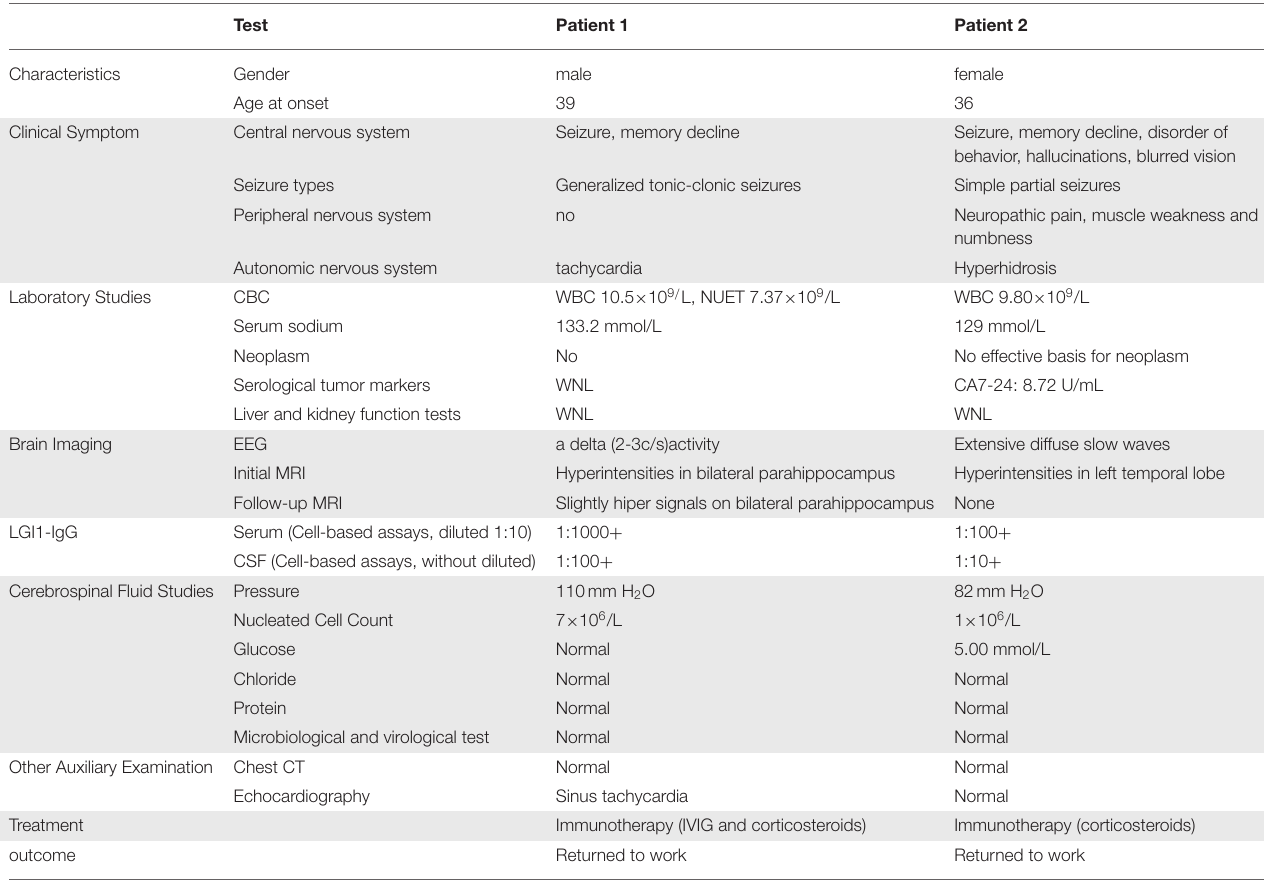
TABLE 1 | Clinical profiles of the two patients.